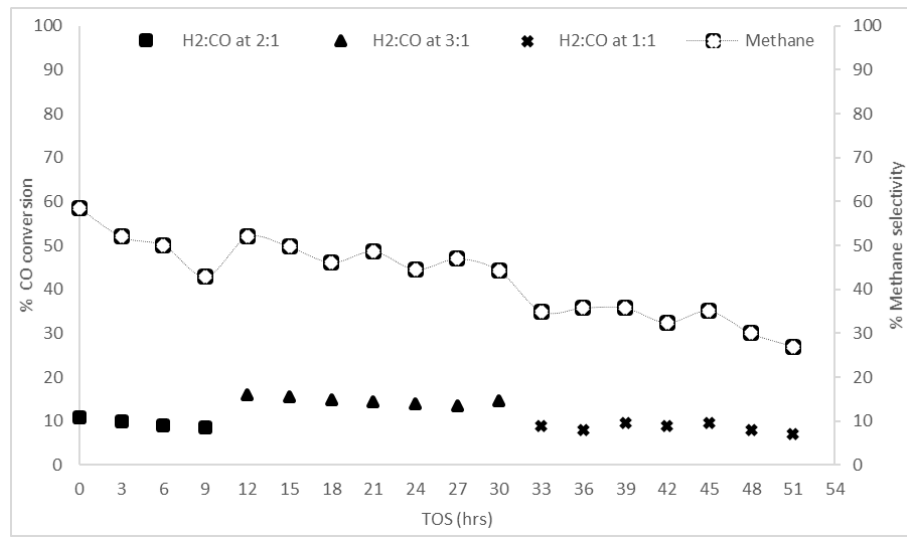
Figure 9. CO conversion and methane selectivity for different feed ratios in Zone D in R4 (refer to Tables 3 and 4 for reaction details).